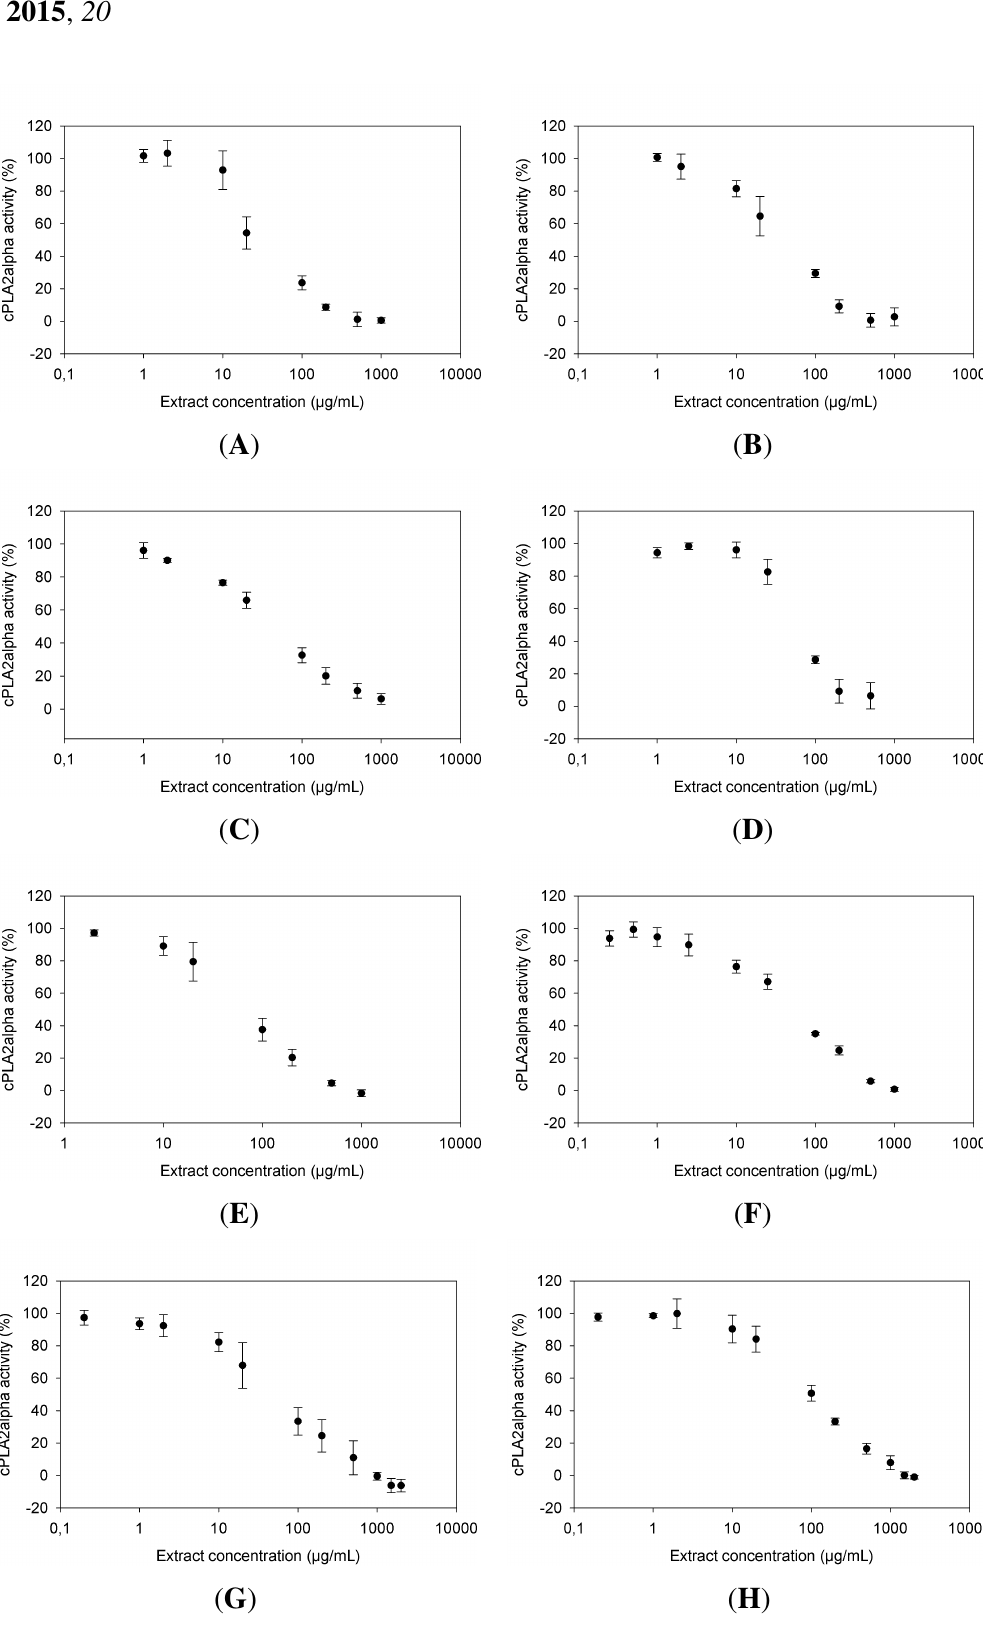
α (cPLA α ) inhibition by Figure 2. Dose-dependence of cytosolic phospholipase A 2 2 extracts of: Ribes nigrum ( A ); Ononis spinosa ( B ); Urtica dioica ( C ); Betula sp. ( D ); Sanguisorba officinalis ( E ); Orthosiphon stamineus ( F ); Petasites hybridus ( G ); and α activity (%) is plotted against extract concentration (µg/mL). Tussilago farfara ( H ). cPLA 2 The x-axes are scaled